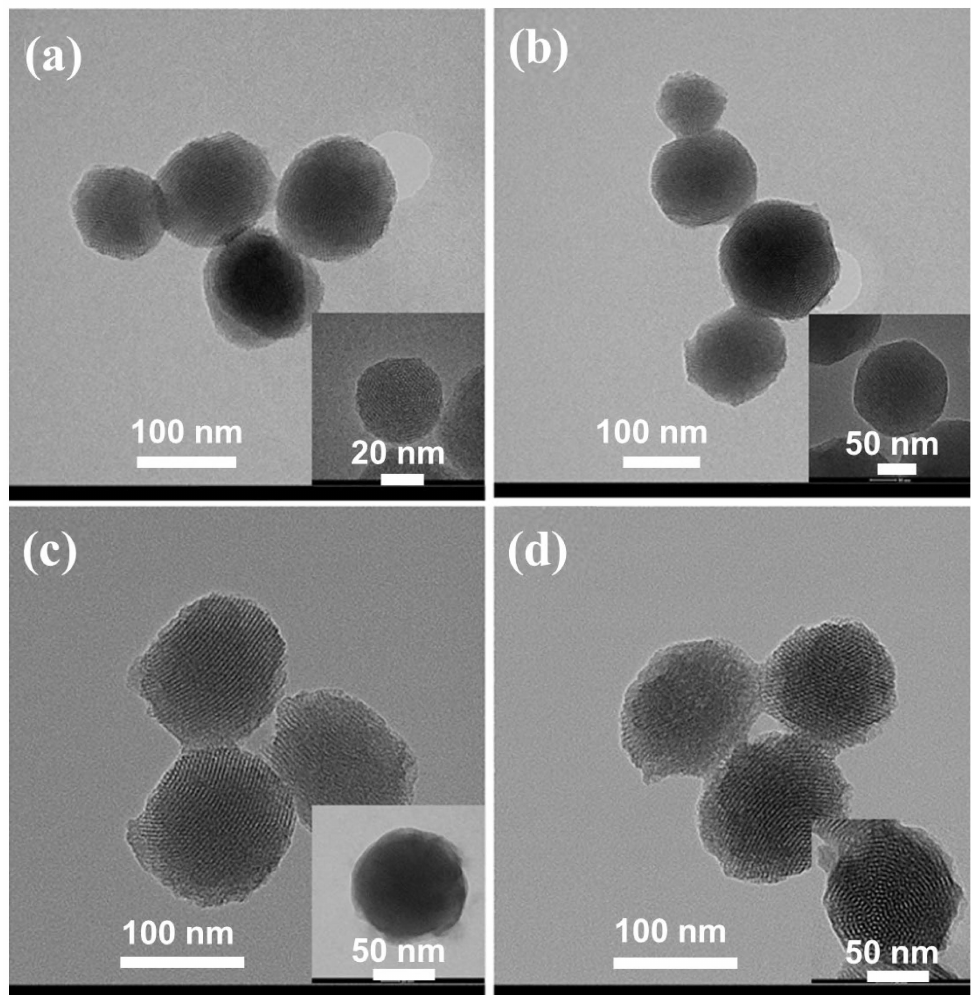
Figure 2. TEM images of ( a ) MCM-41, ( b ) MCM-41-TMSPM, ( c ) MCM-41-PAA, and ( d ) Ca@MCM-